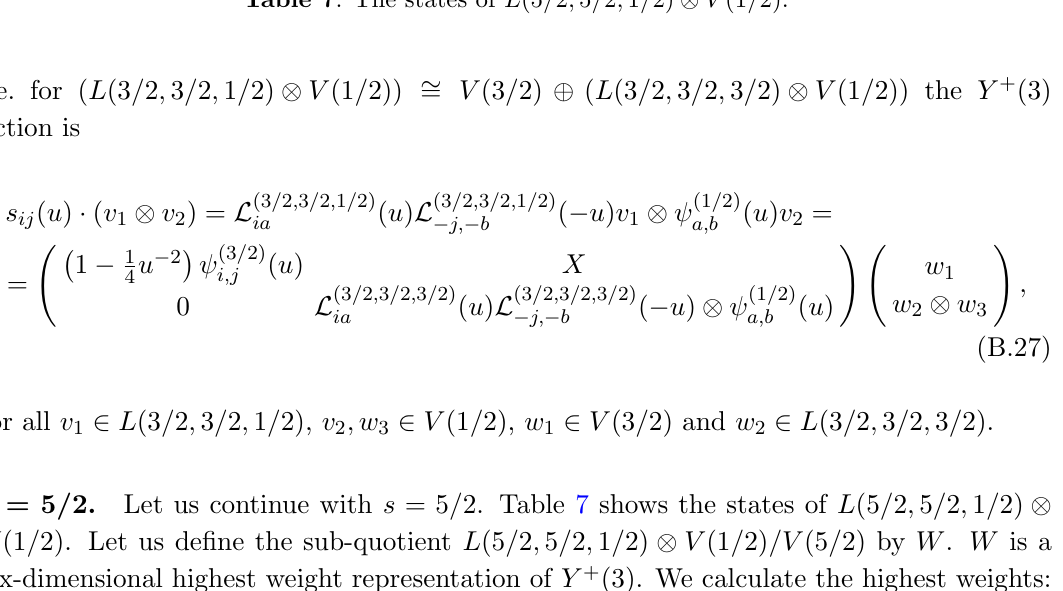
Table 7 . The states of L (5 = 2 ; 5 = 2 ; 1 = 2) (cid:10) V (1 =